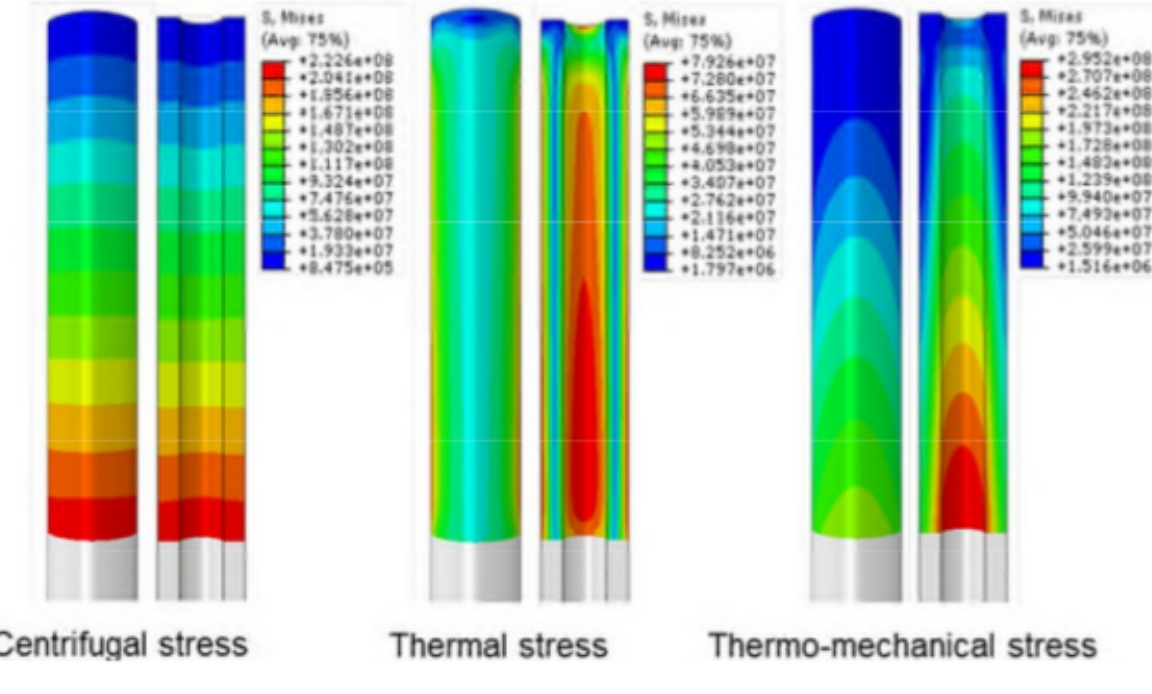
Figure 7: Stress distributions for hot and cold sides.